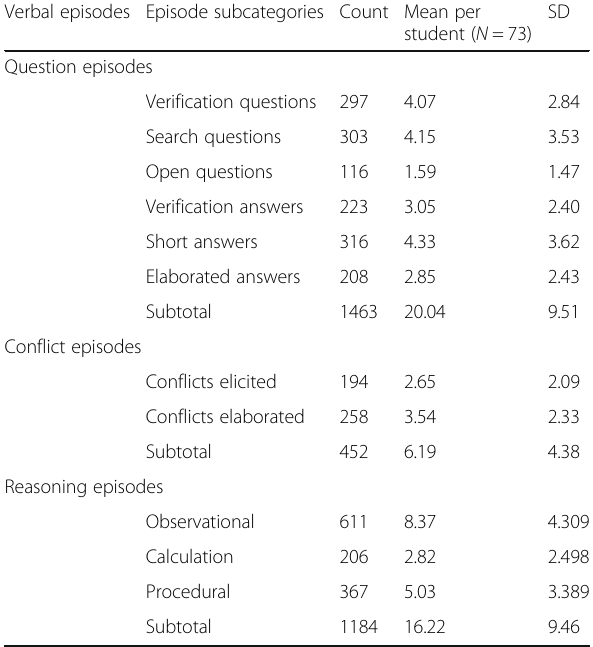
SD student ( N = 73)